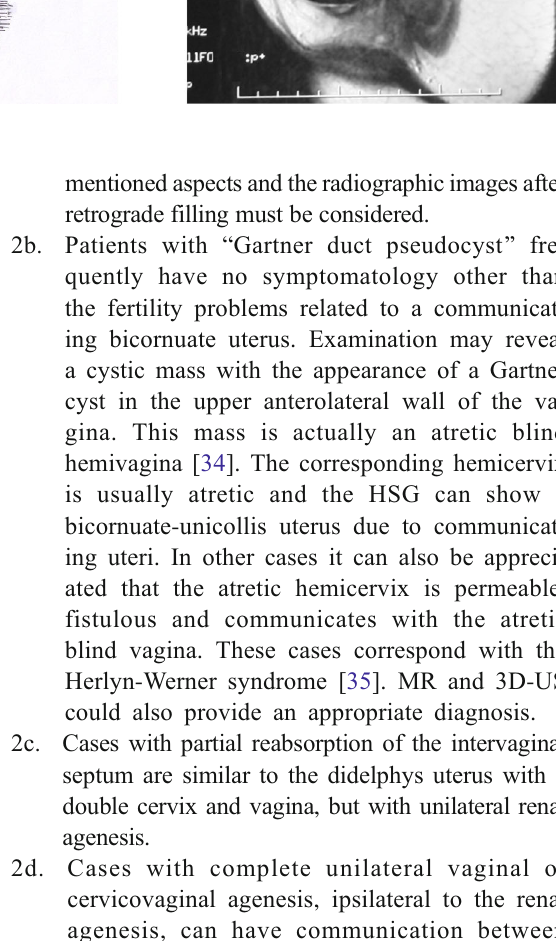
Fig. 2 Cases with agenesis or hypoplasiaofthe urogenital ridge. a Schematic representation and HSG showing right unicornuate uterus and agenesis of all derived organs of the left urogenital ridge. b Schematic representation and MR in a patient with agenesis of the right urogenital ridge andleft Müllerian duct (Rokitansky syndrome with unilateral renal agenesis). The T2-weighted MR image shows a medial sagittal plane with absence of the uterus and vagina (<<). RO, Right ovary; LO, left ovary; RK, right kidney; LK,